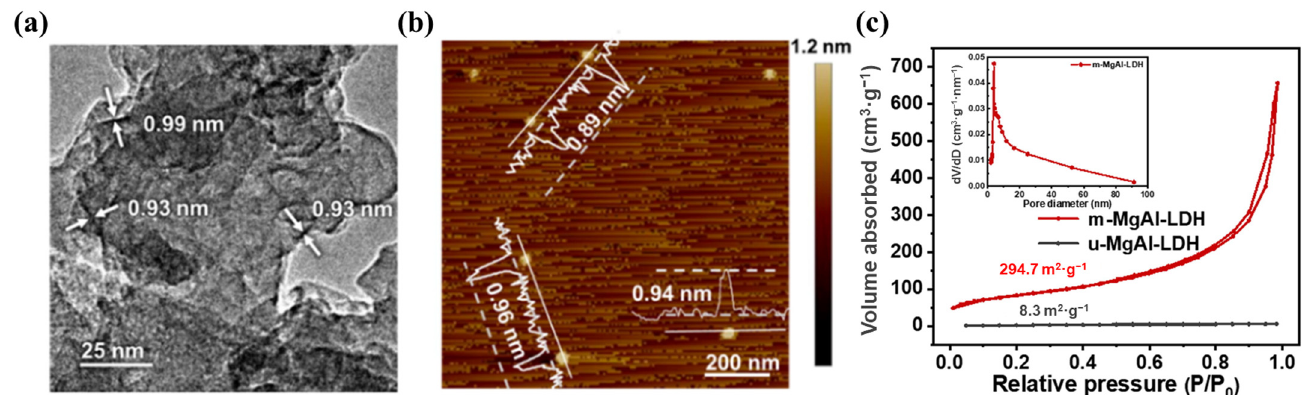
Figure 10. ( a ) HRTEM image and ( b ) AFM image of monolayer MgAl-LDH; ( c ) N 2 adsorption– desorption isotherms for monolayer MgAl-LDH and multilayer MgAl-LDH and pore size distribution of monolayer MgAl-LDH (inset) [106].